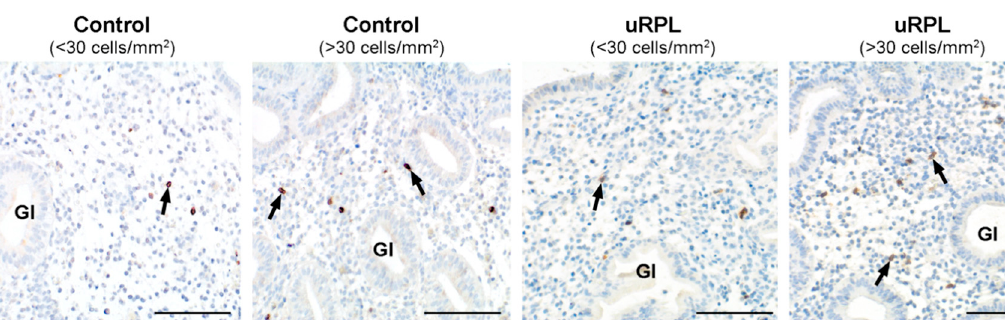
Figure 3. Immunohistochemical localization of CD16 + cells (arrows) in the endometrium of control (<30 cells/mm 2 ) and uRPL cases (<30 and >30 cells/mm 2 ). Gl: endometrial glands. Scale bar = 100 μ m.